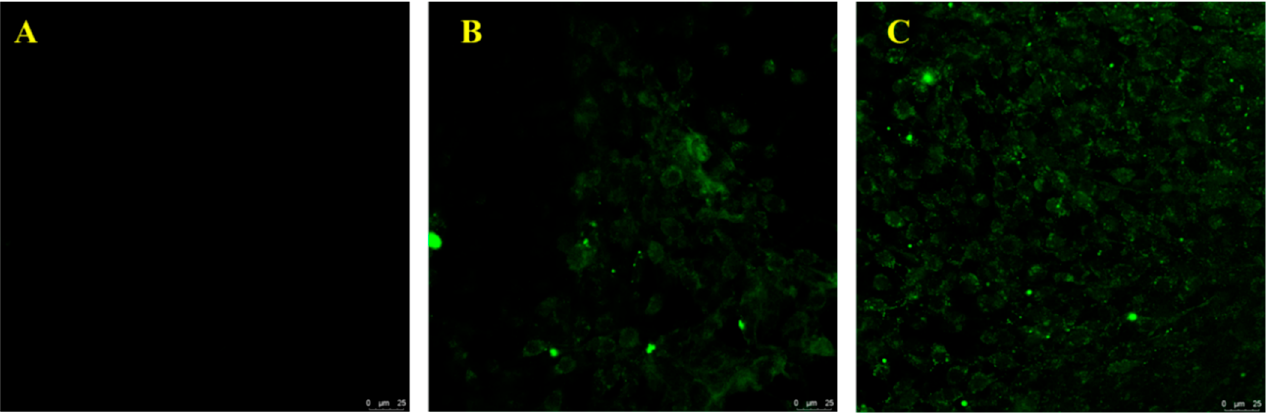
Figure 7. Determination of binding in PC12 cells with PF-2-2 at 0 h ( A ), 6 h ( B ), and 24 h ( C ). The binding site was observed using a confocal microscope at the magnification, the scale is 25 μ m.